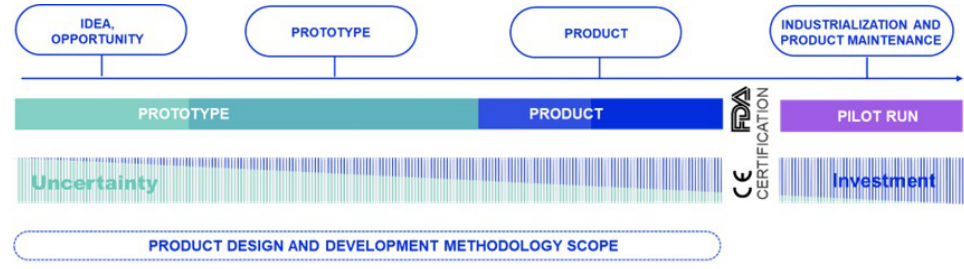
Figure 8. Scope of the proposed methodology.